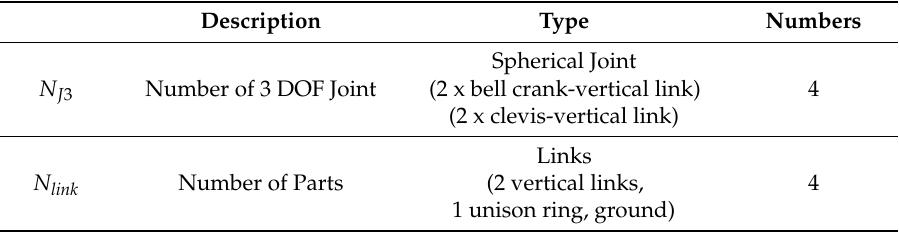
Table 1. Joints and links of the VGV’s link mechanisms below the bell